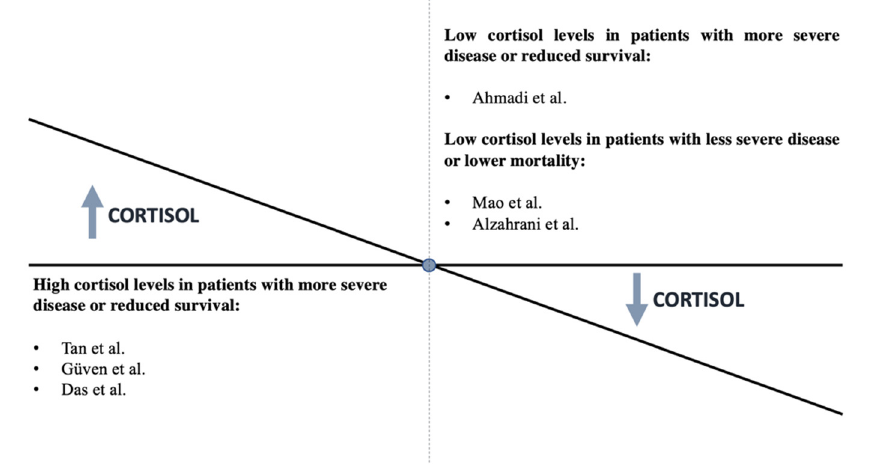
Figure 2. Association between cortisol levels and disease severity